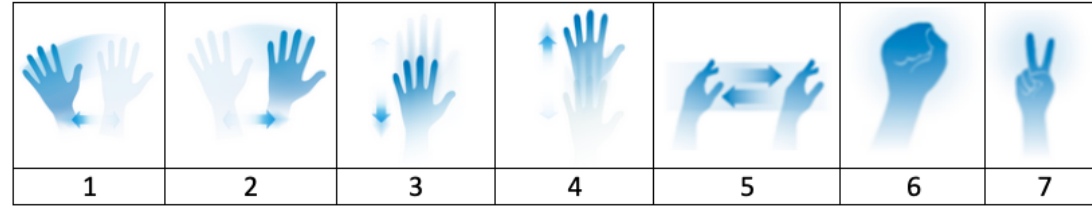
Figure 3. A set of gesture included in presented research. (Based on